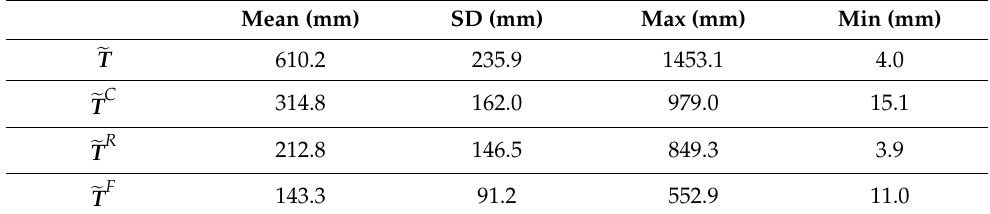
C R F , (cid:101) T and (cid:101) T in the circular path.